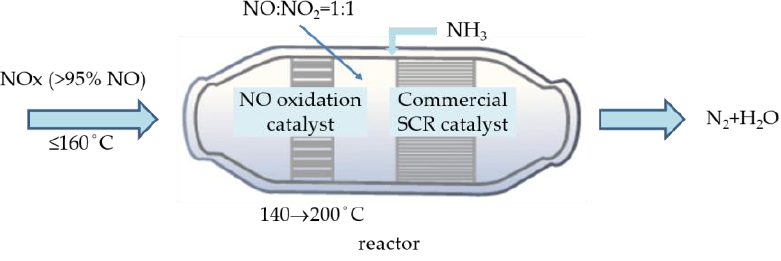
Figure 2. Reaction configuration of SCR with NO oxidation and commercial catalyst.